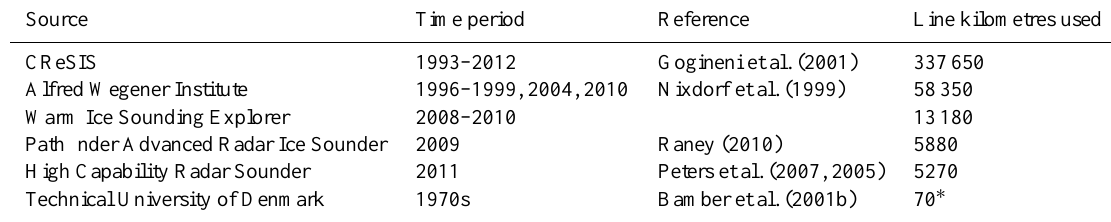
Table 1. Airborne data sources used in this study.